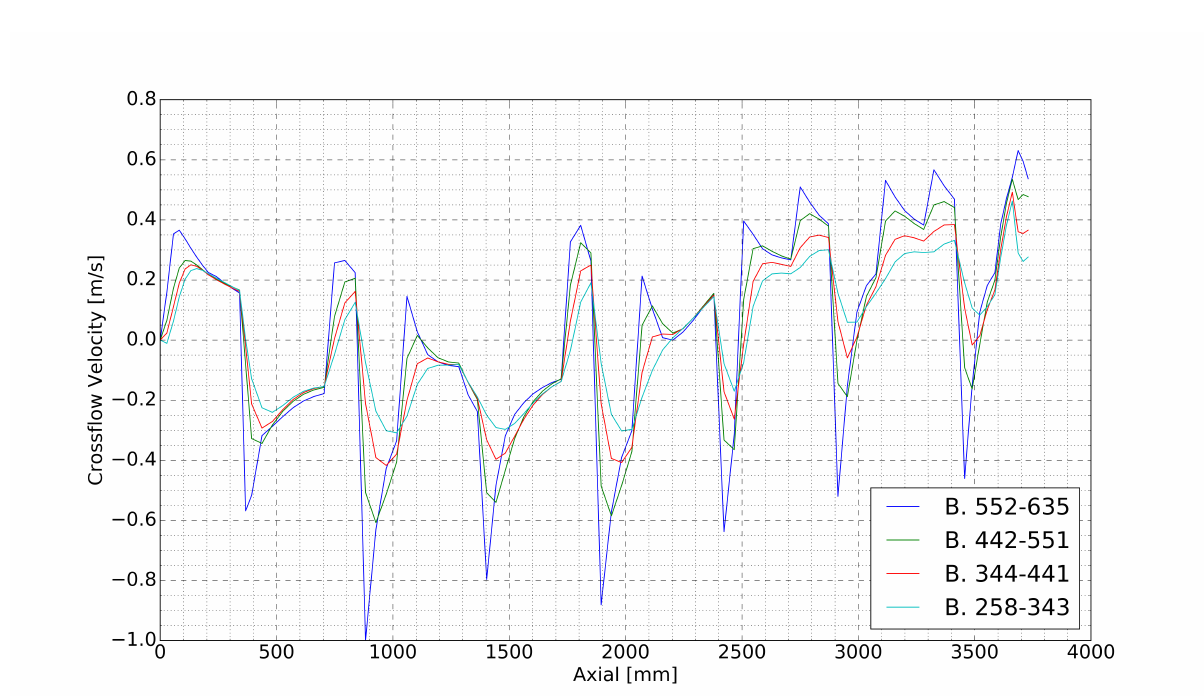
Figure 7. Example of crossflow velocity - variant